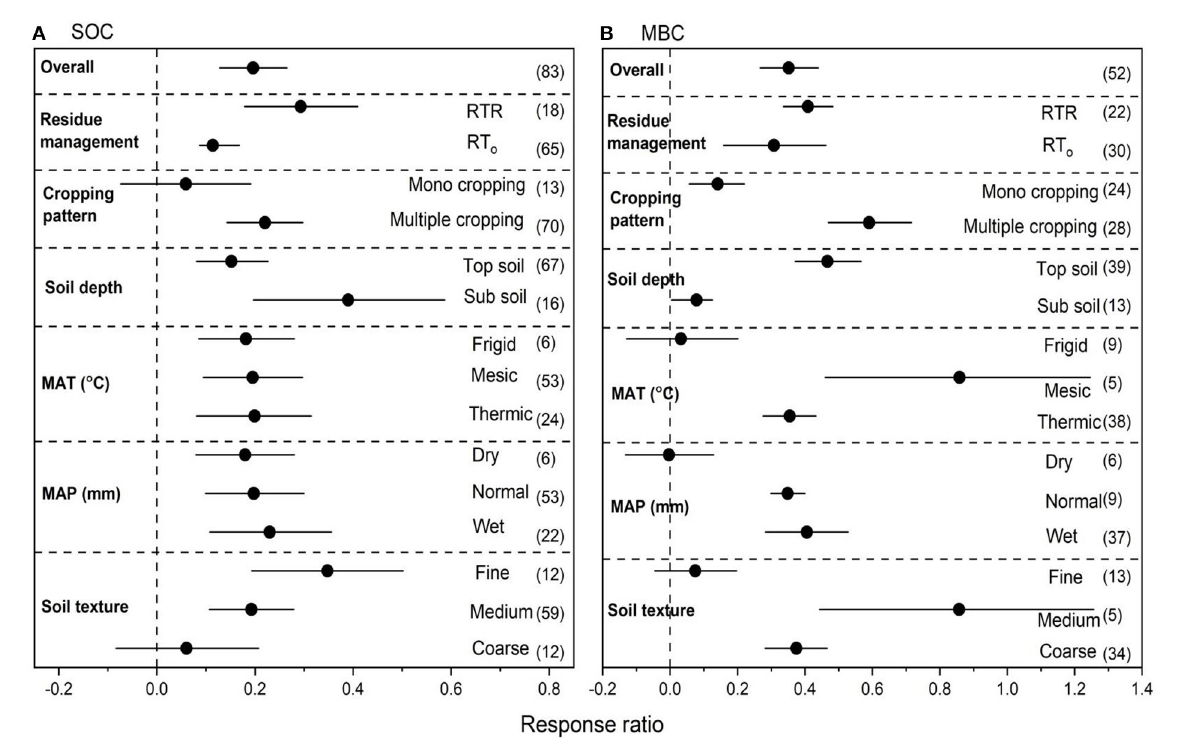
FIGURE6 (A,B) The effect size of soil organic carbon (SOC) and microbial biomass carbon (MBC) with RT compared to CT. If 95% confidence intervals (CIs) do not overlap with zero, there is a substantial difference in the effect size between treatments. Error bars display CIs. The sample size for each variable is displayed next to each bar. The acronyms stand for mean annual temperature (MAT), mean annual precipitation (MAP), retention of residue (RTR), and no residue retention